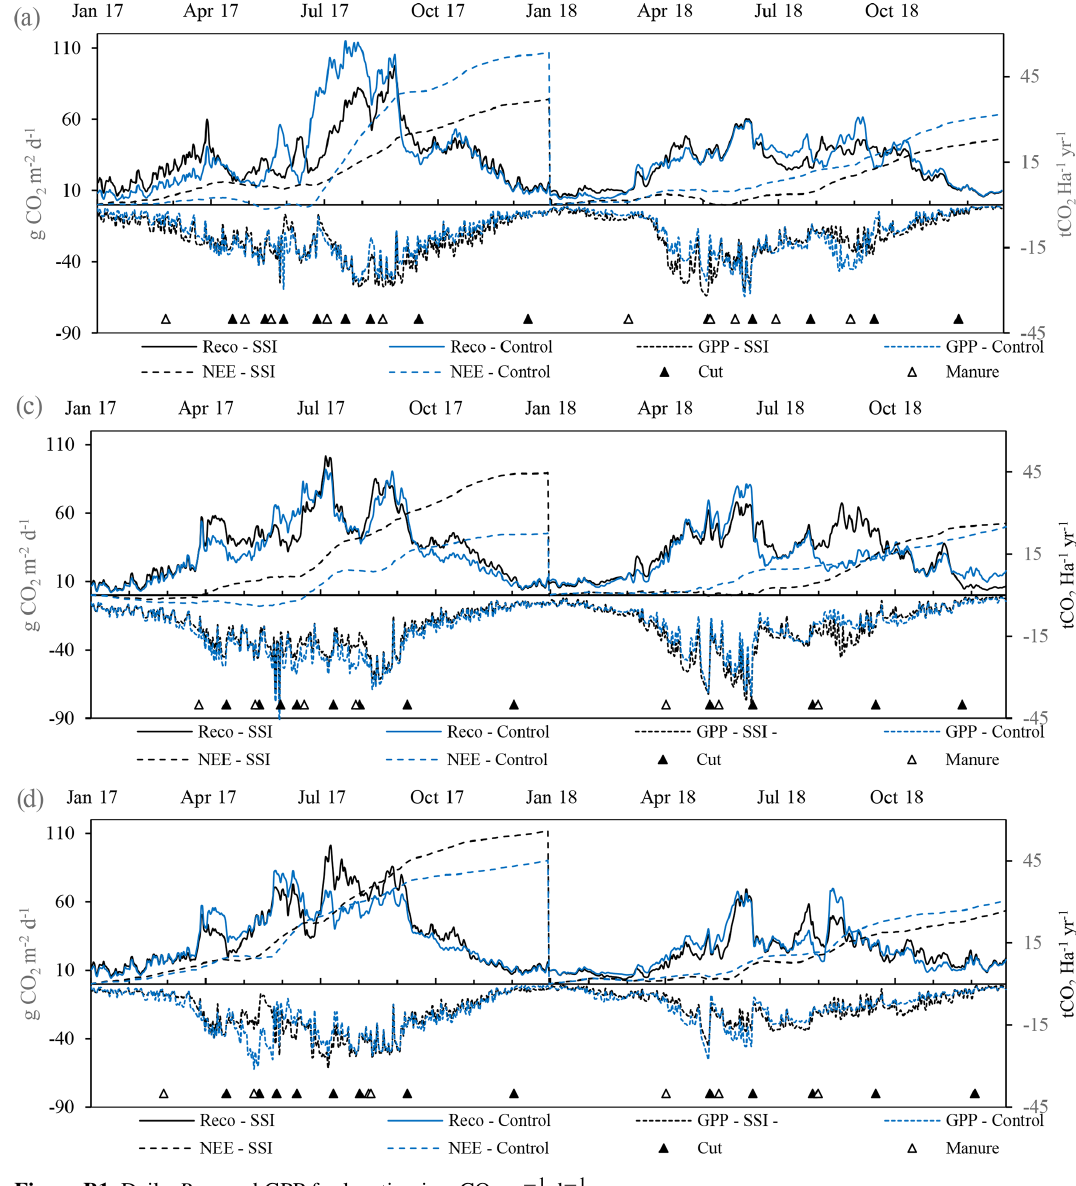
Figure B1. Daily R eco and GPP for location in gCO 2 m − 1 d − 1 on the primary y axis, for control and SSI for locations A, C and D. Accumulative NEE in tCO 2 ha − 1 yr − 1 , for control and SSI, every year starting at